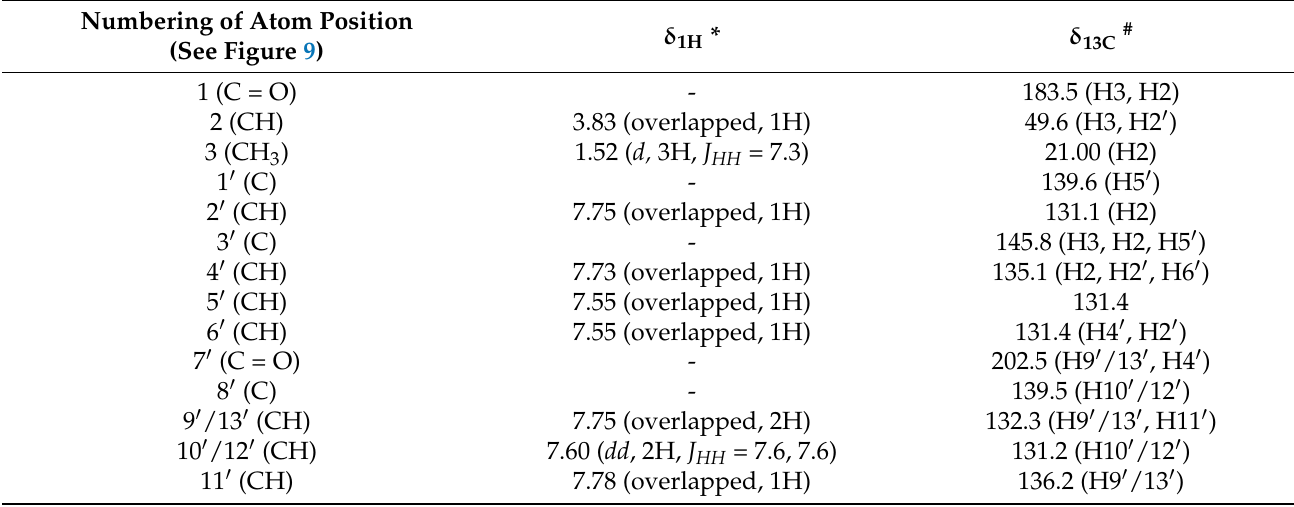
Table 4. The experimental 1 H and 13 C NMR chemical shifts δ (ppm) for racemic KP in the presence of β -CD (equimolar solution, sample 3 ) in D 2 O, temperature of 25 ◦